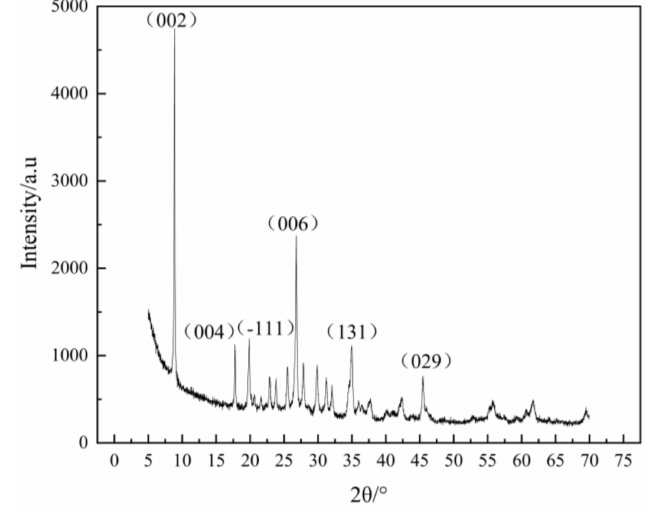
Figure 13. The XRD pattern of muscovite.